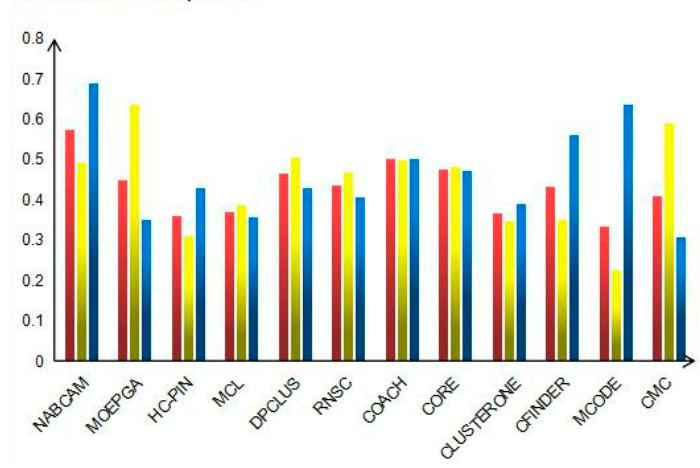
Figure 6. Precision , recall and f-measure values of various algorithms on the DIP dataset.